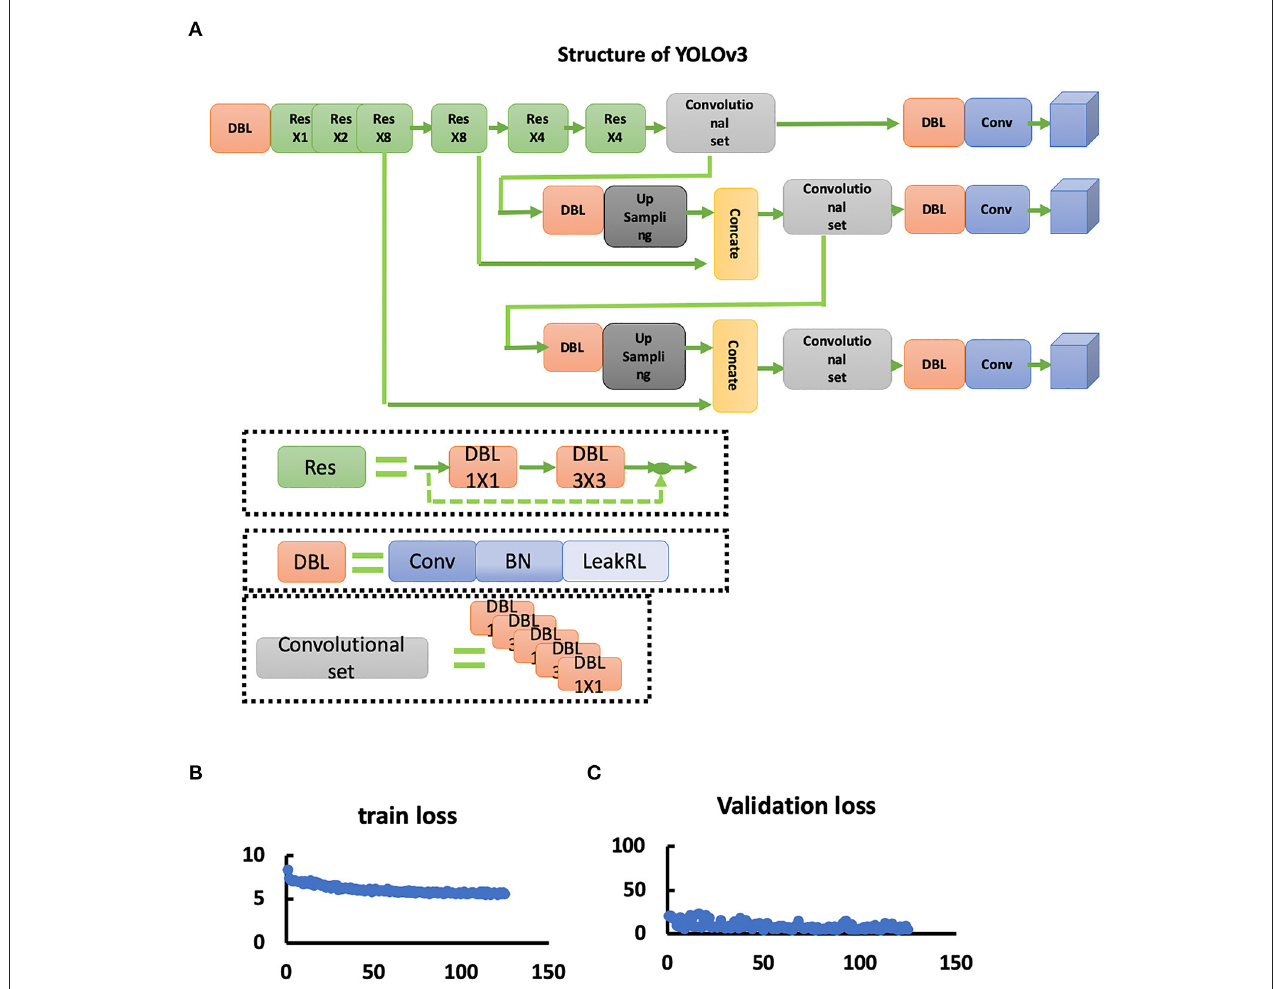
FIGURE 3 | YOLOv3 network. (A) Structure of the YOLOv3 network. (B) Train loss curve of the YOLOv3 network. (C) Validation loss curve of the YOLOv3 network.